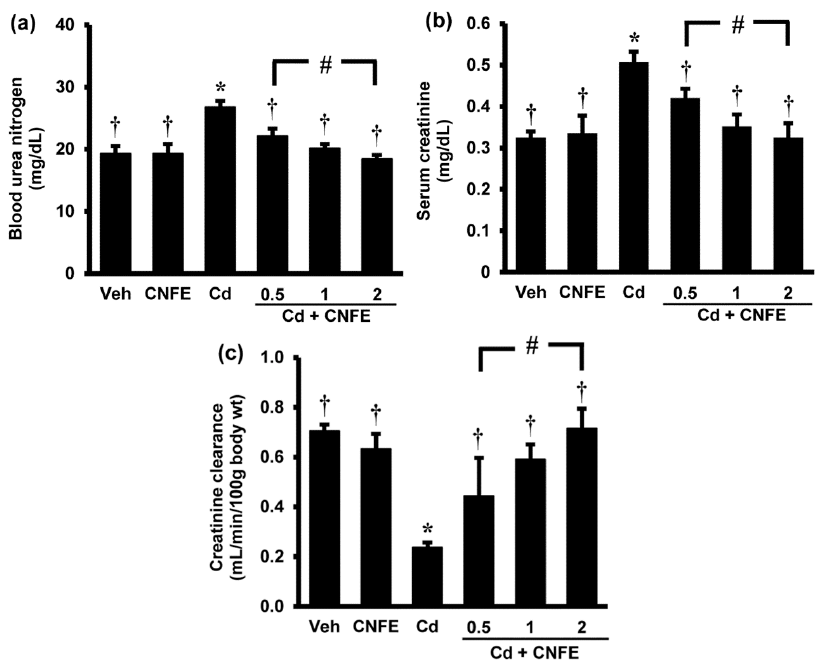
Figure 2. Effects of cadmium and CNFE on renal function. ( a ) Blood urea nitrogen; ( b ) serum creatinine, ( c ) creatinine clearance. Values are mean ± SEM ( n = 6). Veh: vehicle-treated control group; CNFE: C. nervosum fruit extract-treated group; Cd: cadmium-treated group; Cd + CNFE (0.5, 1, 2): cadmium plus CNFE-treated groups at 0.5, 1, 2 g/kg, respectively. * p < 0.05 vs. Veh, † p < 0.05 vs. Cd, # p < 0.05 between Cd + CNFE.